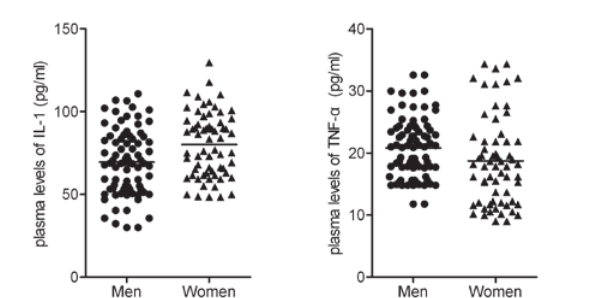
Figure 2b: Columnar scatter graph showed plasma levels of IL-1 (left) and TNF-α (right) of each gender, respectively. Round represent males and triangles represent females. Horizontal line represents the average of each